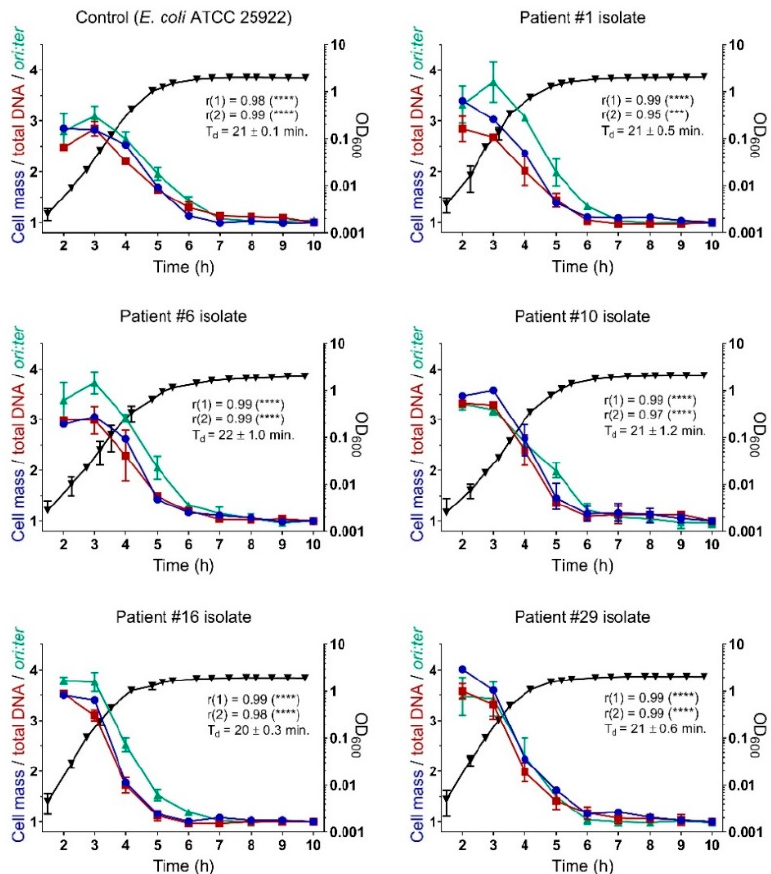
Figure 2. Controlled growth of selected clinical E. coli urine isolates in Lysogeny Broth (LB) batch cultures in vitro. E. coli ATCC 25922 was used as a control. Bacterial growth measured as optical density (OD 600 ) (black triangles), ori:ter (green triangles), cell mass (blue circles), and total DNA content per cell (red squares). The latter two measurements were made by flow cytometry and are presented as relative to those of the same isolate during the late stationary phase (i.e., the samples collected at 10 h of incubation). An average of 30,000 bacterial cells were analyzed by flow cytometry per sample. Data are presented as mean ± SD of three independently repeated experiments. Time (h) represents hours of incubation. Doubling time (T d ) is inferred from OD 600 measurements during the mid-exponential growth (approximately 3 h of incubation). Pearson’s correlation between cell mass and total DNA content per cell is shown as r(1), and the correlation between the cell mass and the ori:ter as r(2), respectively. Excluded from correlation analyses were measurements at 10 h of incubation, since these were used as a denominator in the flow cytometry data (i.e., relative cell mass and relative total DNA content). ***, p ≤ 0.001; ****, p ≤